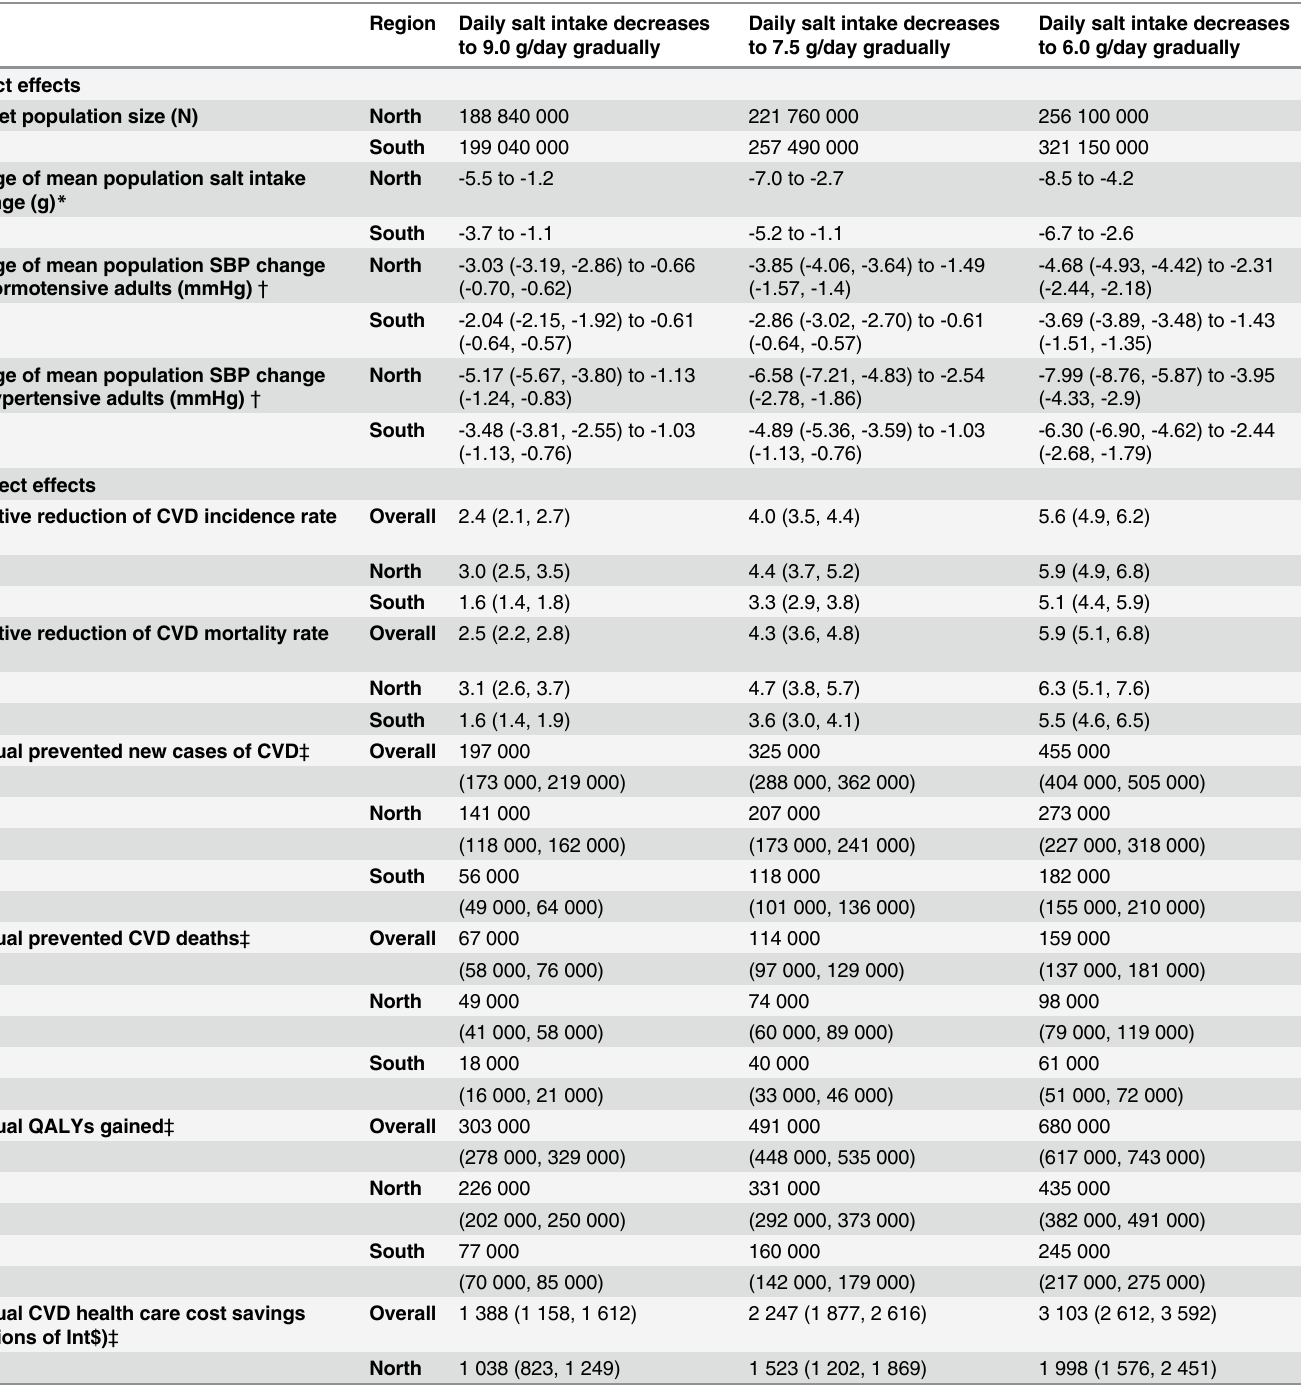
Table 3. Simulated SBP reductions and annual cardiovascular disease outcomes (coronary heart disease and stroke combined) after achieving dietary salt reduction goals in China, from 2010 to 2019, according to the CVD Policy